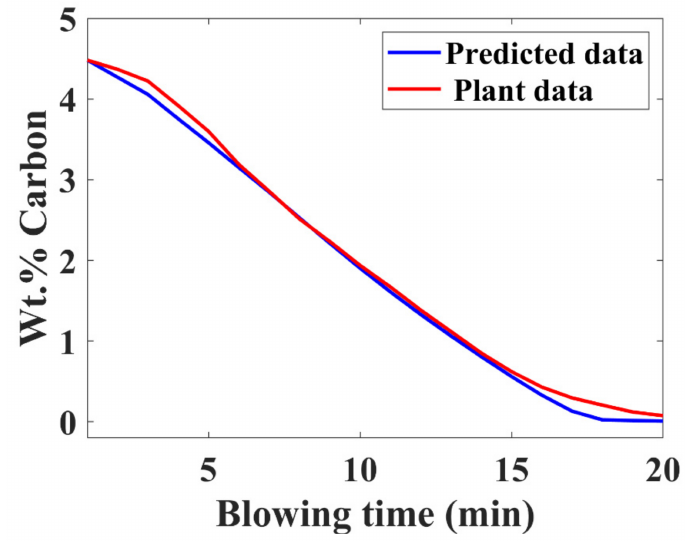
Figure 8. Variation in carbon wt % with blowing time for plant data and model